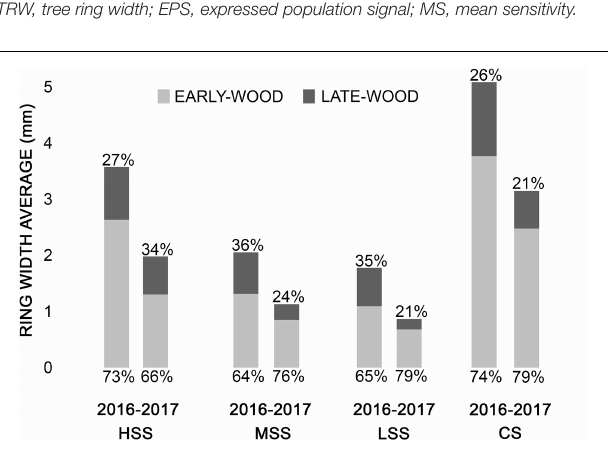
FIGURE 3 | Annual ring width of the 2016 and 2017 reported in each site. In gray the early-wood and in black the late-wood with the percentage of growth, respectively.